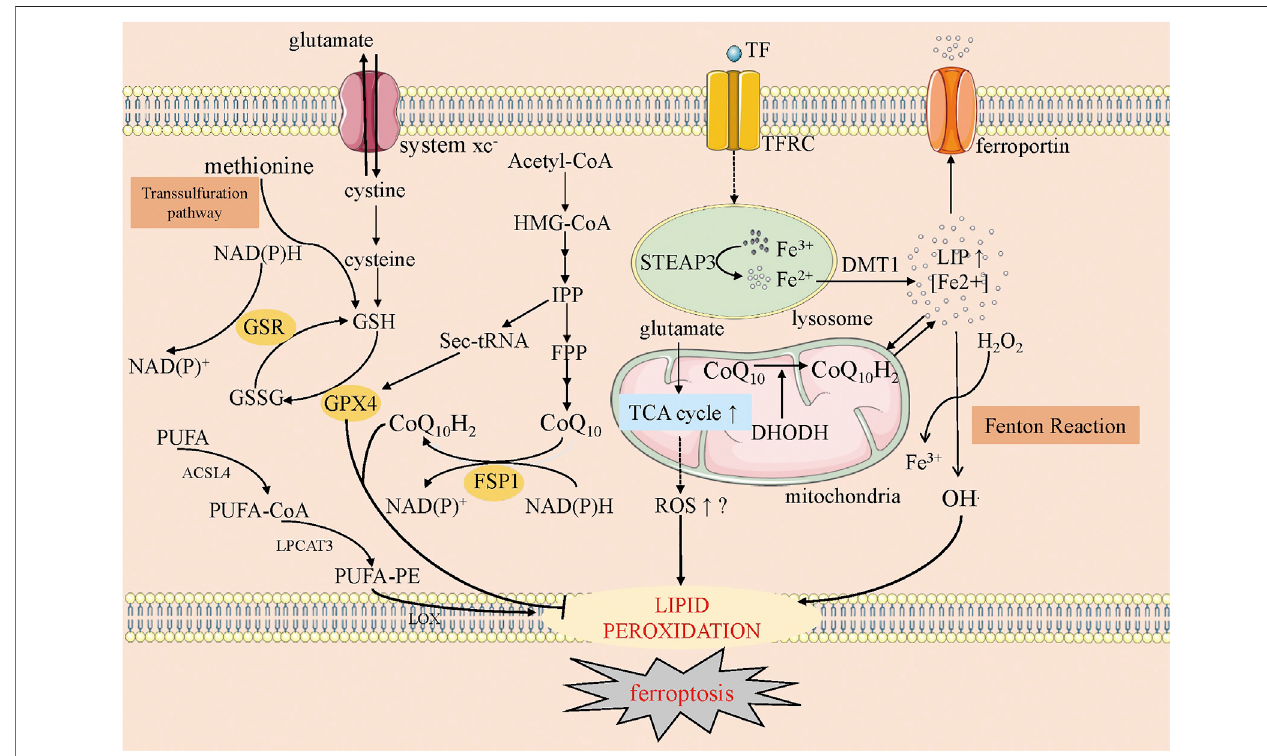
FIGURE 2 | The overview of ferroptosis. This fi gure shows fi ve systems regulating ferroptosis. The fi rst one is the anti-oxidative GSH-GPX4 pathway, in which system xc − , transsulfuration way, GSH and GPX4 involve. The second one is the mevalonate pathway, where CoQ 10 is produced. The third one is iron metabolism, where the Fenton reaction happens and the starter of lipid peroxidation, OH . , is produced. The fourth one is mitochondria, on whose membrane oxidative CoQ 10 is catalyzed into reductive CoQ 10 (CoQ 10 H 2 ) and DHODH could inhibit this process. Meanwhile, the increased ROS along with the increased TCA cycle may help ferroptosis. The fi fth one is lipid metabolism, in which PUFA is catalyzed into peroxidative lipid fi nally. GSH, glutathione; GSSG, glutathione disul fi de; GSR, glutathione- disul fi de reductase; FSP1, ferroptosis suppressor protein-1; GPX4, glutathione peroxidase 4; HMG-CoA, 3-hydroxy-3-methyl glutaryl coenzyme A; IPP, isopentenyl pyrophosphate; FPP, farnesyl pyrophosphate; TF, transferrin; TFRC, transferrin receptor; STEAP3, six-transmembrane epithelial antigen of prostate 3; DMT1, divalent metal transporter 1; LIP, labile iron pool; TCA cycle, Tricarboxylic Acid cycle; DHODH, dihydroorotate dehydrogenase; ROS, reactive oxygen species; PUFA, polyunsaturated fatty acids; PE, phosphatidylethanolamine; ACSL4, acyl-CoA synthetase long-chain family member 4; LPCAT3, lysophospholipid acyltransferase 3; LOX,